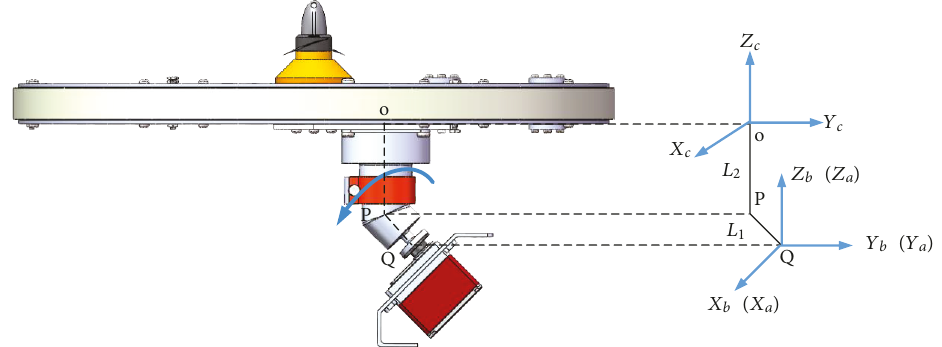
Figure 7: Simpli fi ed coordinate model of the wheel and the transformable